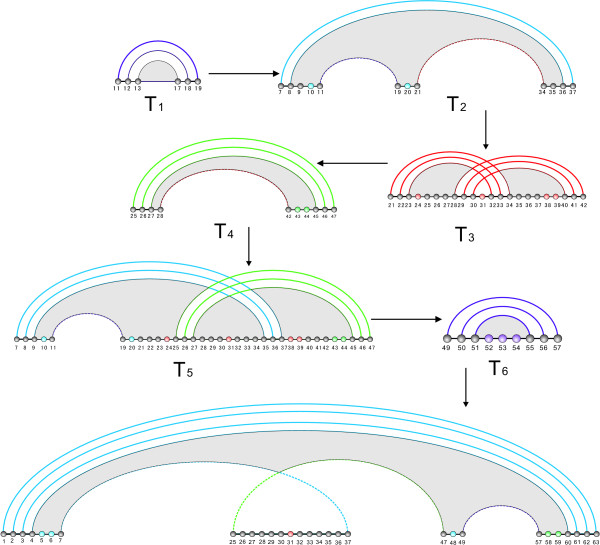
Ordering. Linear ordering of loops: a1 = [11, 19], b1 = [10, 20], a2 = [7, 37], b2 = [5, 39], a3 = [21, 42], b3 = [20, 44], a4 = [25, 47], b4 = [24, 48], a5 = [7, 47], b5 = [5, 48], a6 = [49, 57], b6 = [48, 59], a7 = [1, 63], b7 = [1, 65].